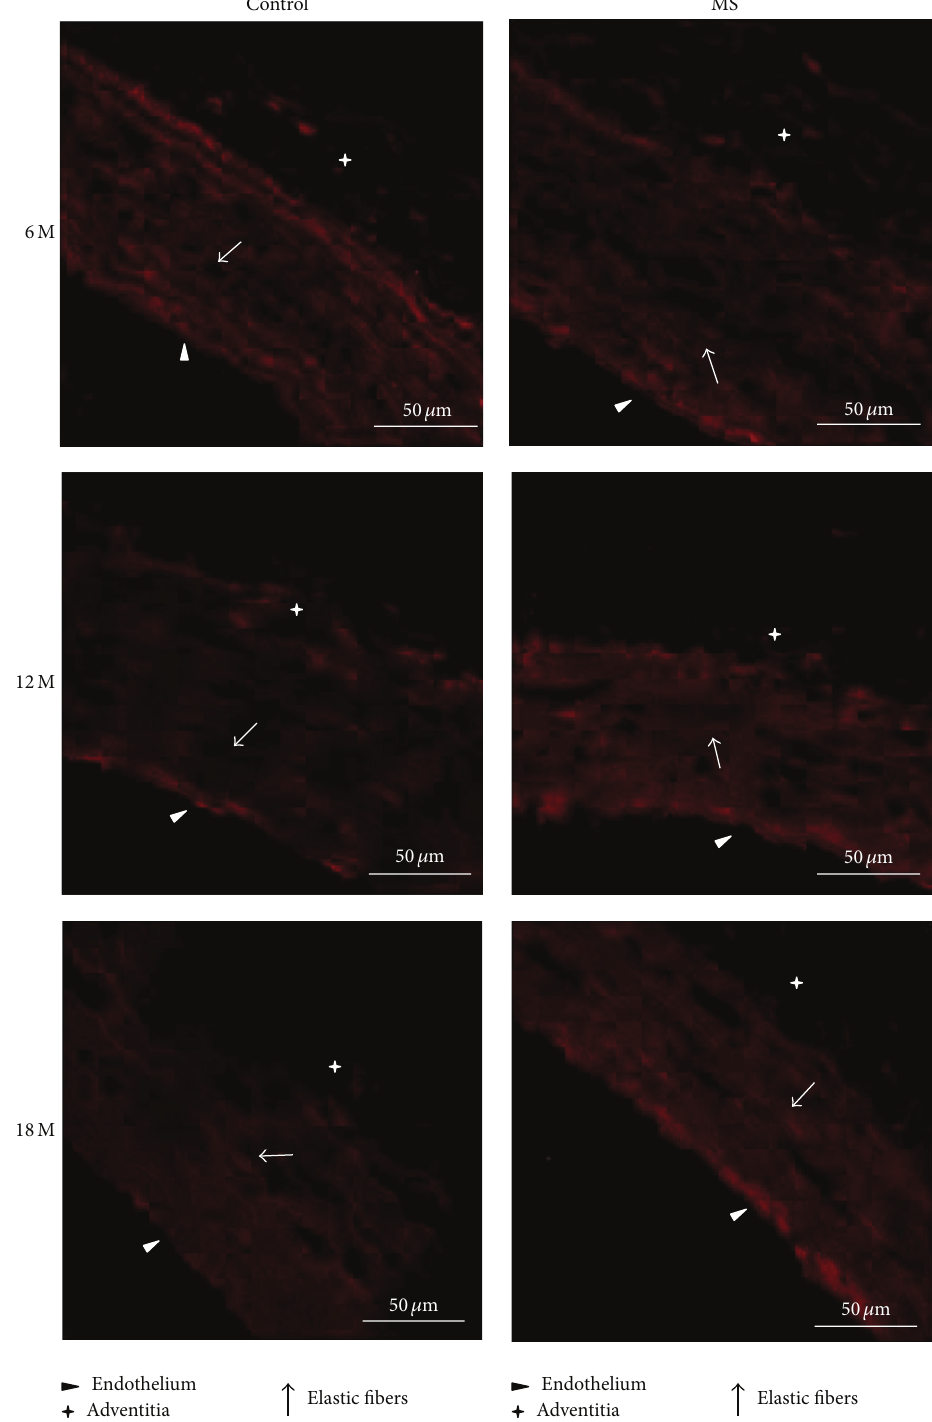
Figure 5: Illustrative images ( × 60) showing receptor Mas immunofluorescence in aortas of control and MS rats aged 6, 12, and 18 months. Preparations were stained with Tex Red. Scale bar = 50 𝜇